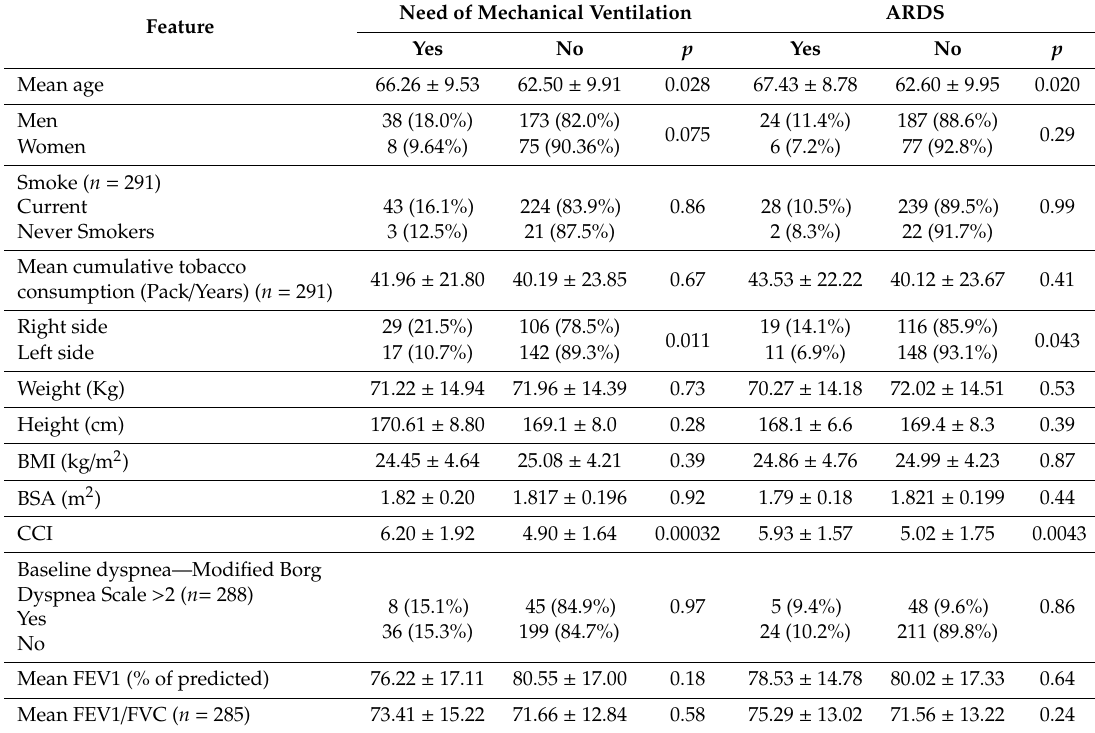
Table 3. Correlations between patient’s and tumor related factors with occurrence of respiratory failure requiring intubation and